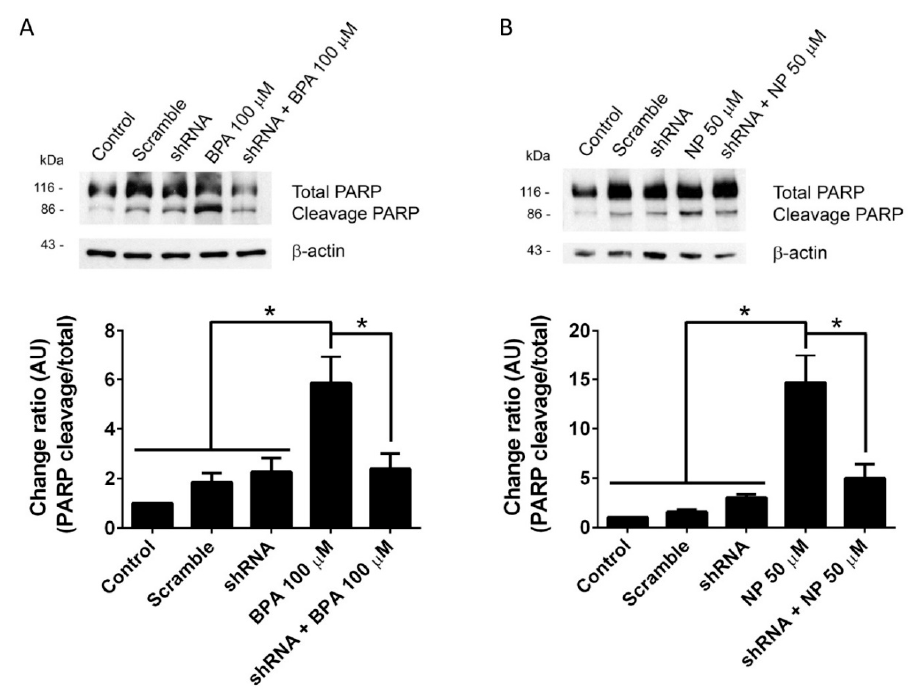
Figure 2. Silencing of ADAM17 prevents poly (ADP-ribose) polymerase (PARP) cleavage induced